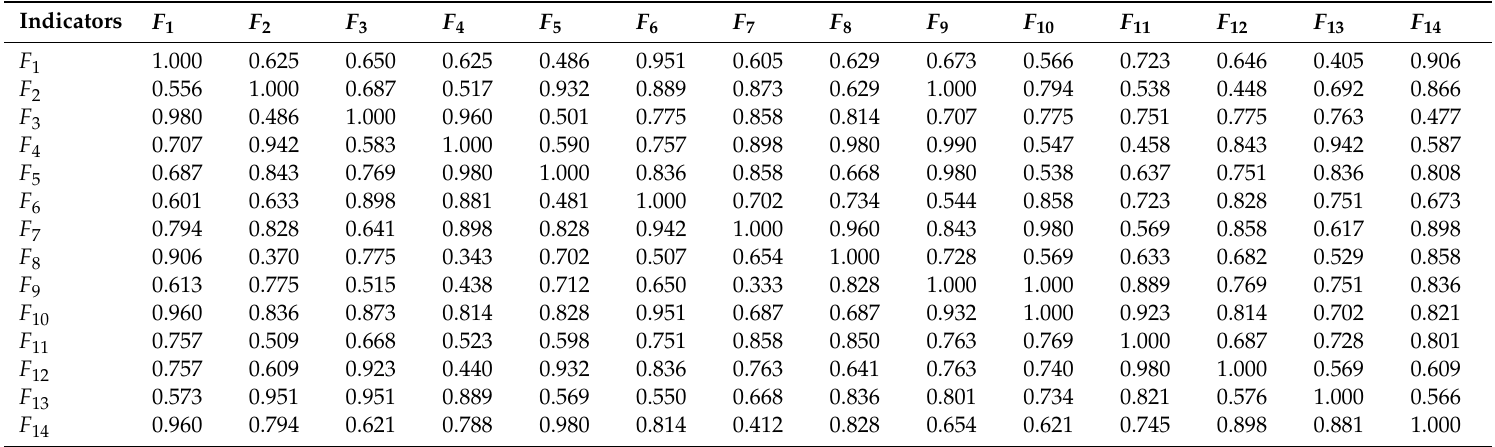
Table 4. The gray relation coe ffi cient relation matrix ξ 1